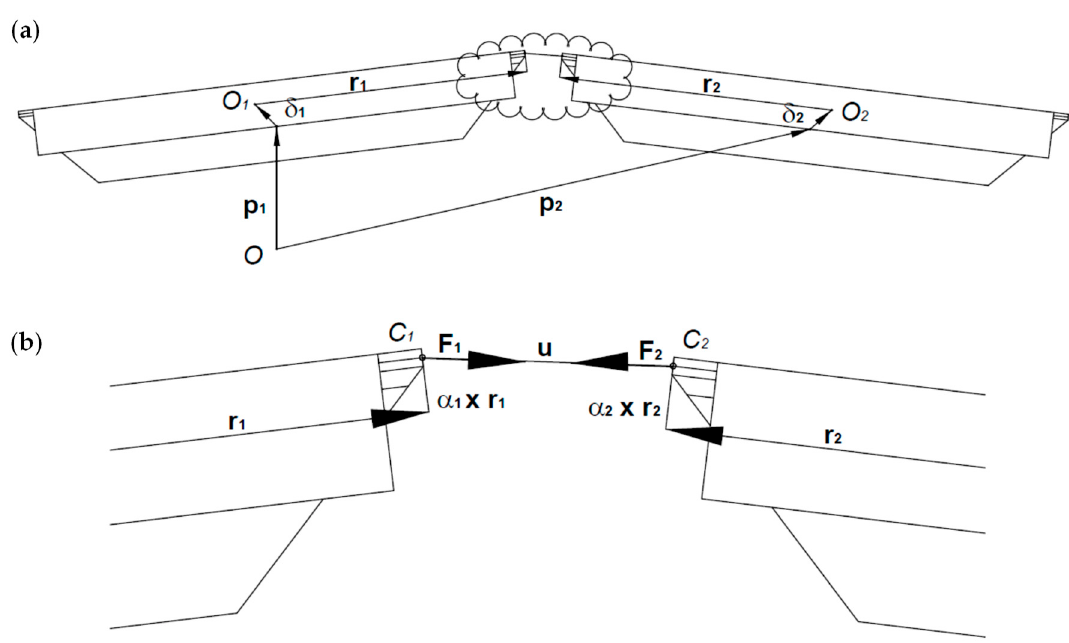
Figure 2. The connected breakwaters at some time instant: ( a ) The side view of the connected breakwaters; ( b ) The zoomed view of the connection.